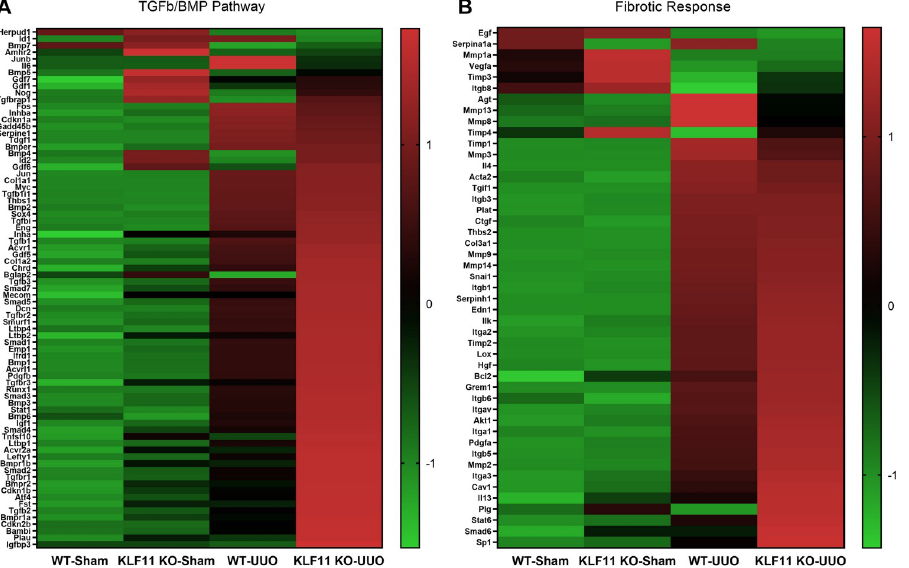
Fig 4. Analysis of differentially expressed genes of TGF- β /BMP/Fibrotic pathways between the KLF11 KO vs WT (Sham and UUO). Heatmap for (A) TGF- β /BMP pathway (B) Fibrotic response were generated using GraphPad Prism version 8.2.1. Color scale shows high and low expressions as red and green,